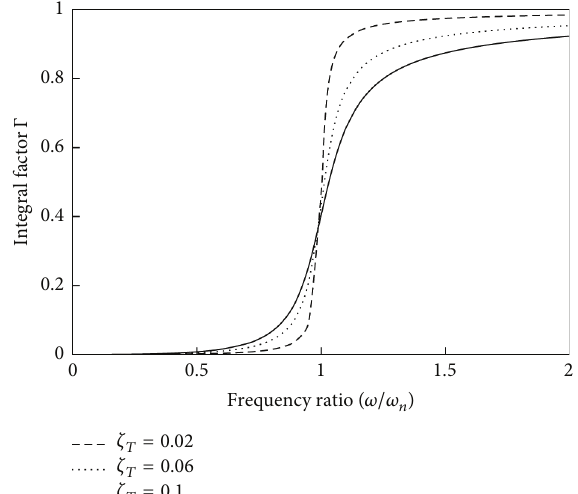
Figure 8: Integral factor for mean square load voltage of an EMEH subjected to band-limited Gaussian white